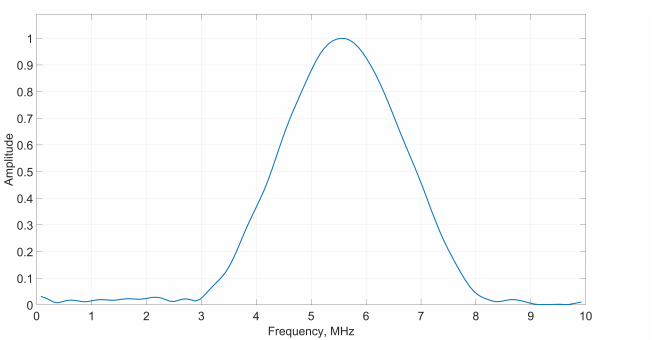
Figure 6. The magnitude of transducer pulse spectrum.